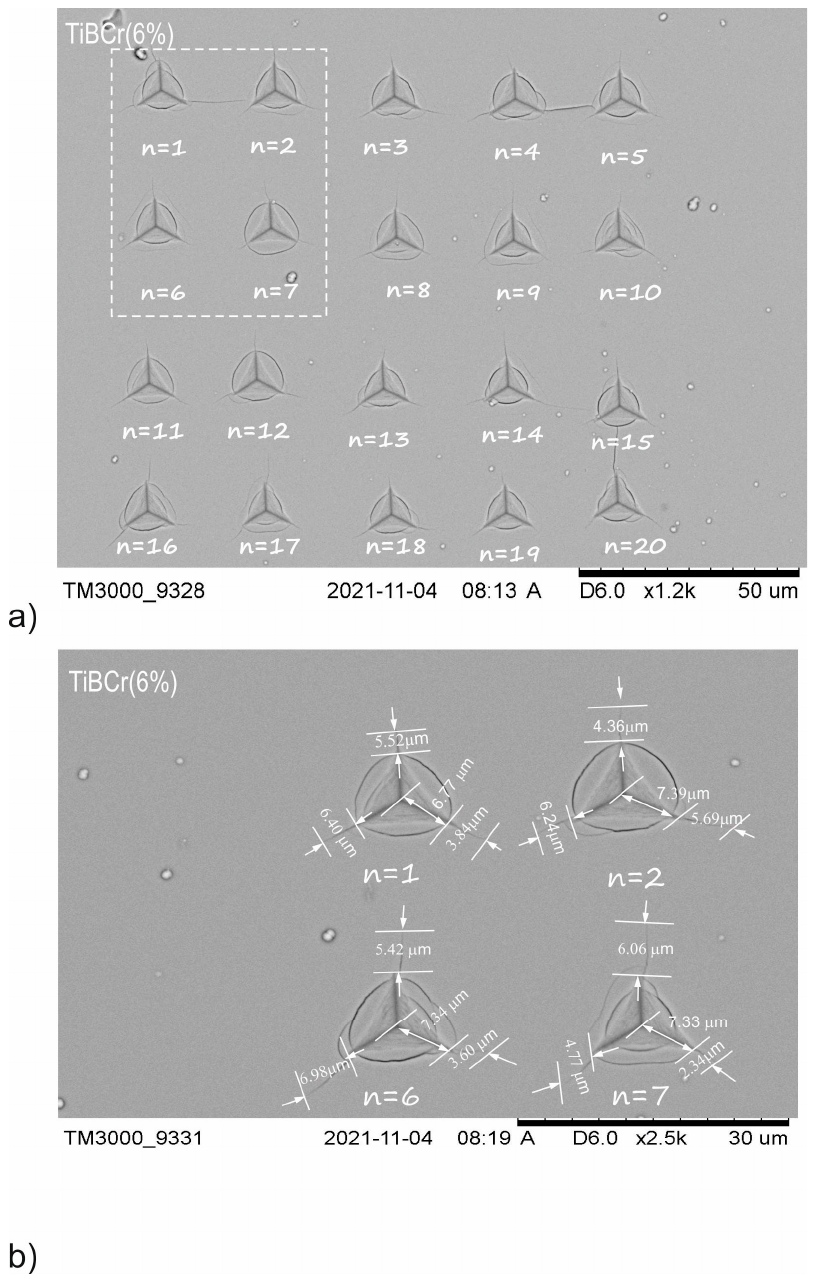
Figure 7. SEM images of groups indentations used for TiBCr (6%) of fracture toughness analysis: ( a ) series of 20 indentations at a load of P critical = 350 mN; ( b ) representation of crack lengths for different indentations where n = 1, 2, 6, 7.